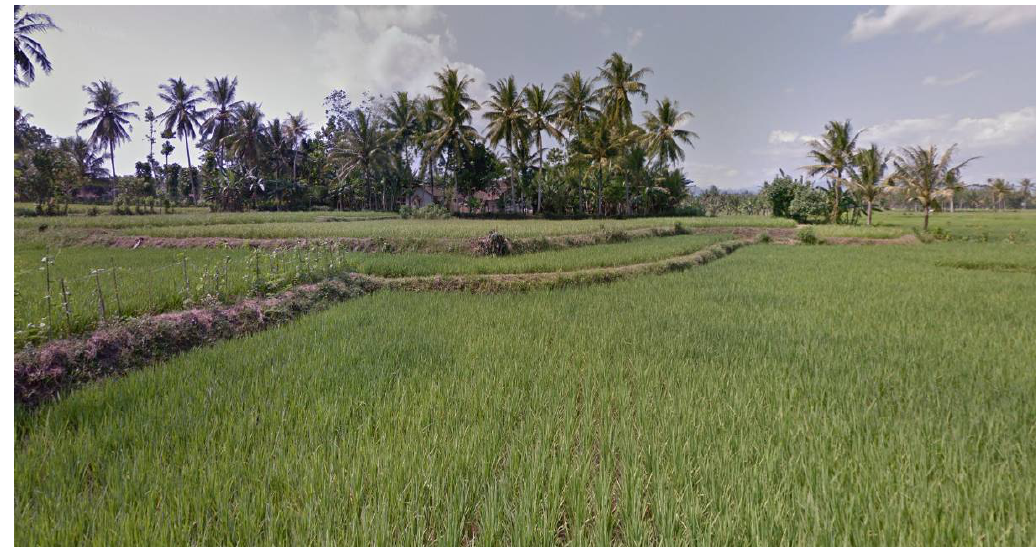
Figure 6. Delay measurement scheme.